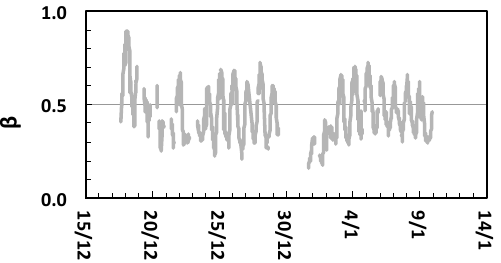
Figure 6. December 2011 time series for β , the fraction of the 17 O excess originally associated with the OH radical that is preserved against isotopic exchange with